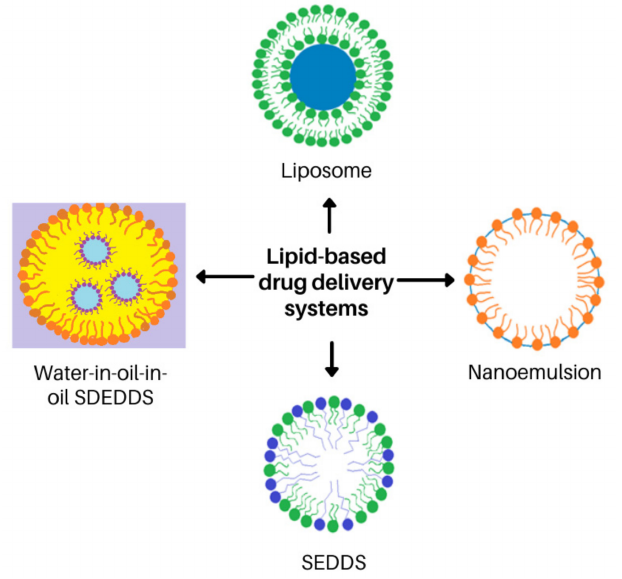
Figure 5. Lipid-based drug delivery systems